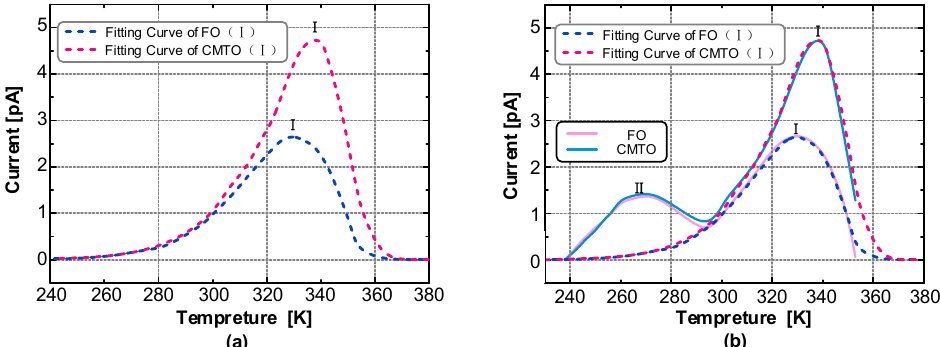
Figure 11. ( a ) Peak I fitting curve of FO and CMIO, ( b ) Comparison of Peak I fitting and measured curves.